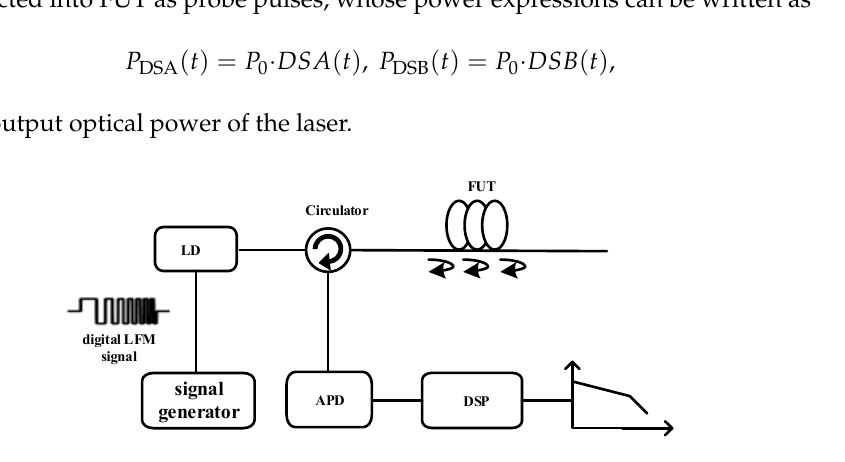
Figure 1. Schematic block diagram of the digital LFM-based optical time-domain reflectometry method. LD: laser diode; APD: avalanche photodiode; FUT: fiber under test; DSP: digital signal processing.